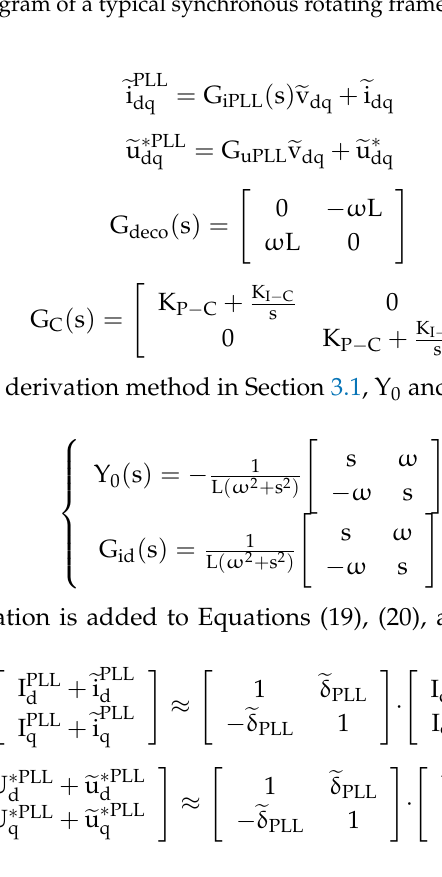
Figure 9. The block diagram of a typical synchronous rotating frame based current control inverter.